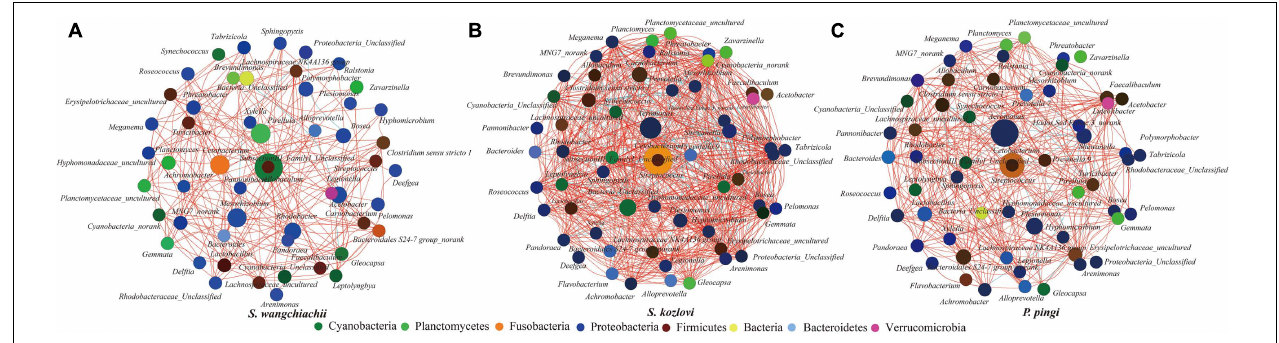
FIGURE 4 | Co-occurrence analysis of the gut microbes (genus level) of the three cold-water fishes (with Spearman index; ρ = 0.5) (A–C) . The top 60 genera were used to generate the co-occurrence networks. The node represents the bacteria genus, the size of the node represents the relative abundance, and the color indicates their taxonomic assignment. The red line between the nodes represents a positive correlation, and the blue line indicates a negative correlation.